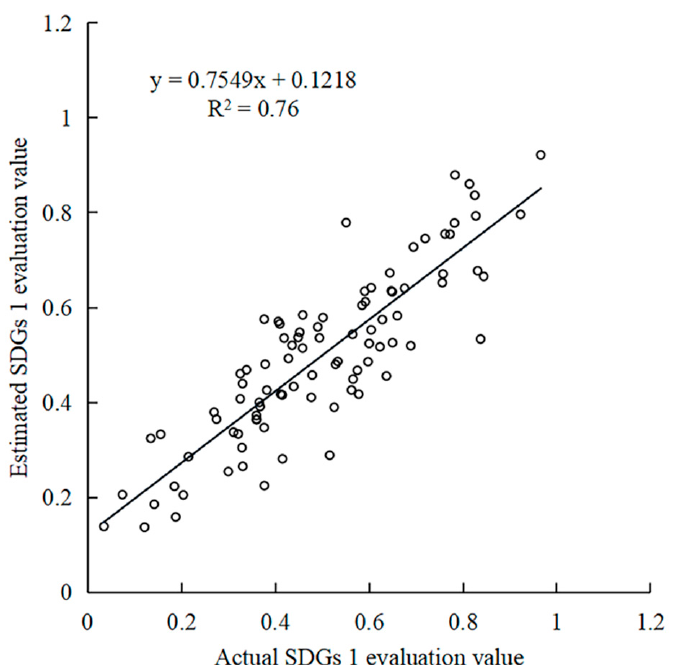
Figure 5. Scatter plot of the estimated and actual SDG 1 evaluation values.